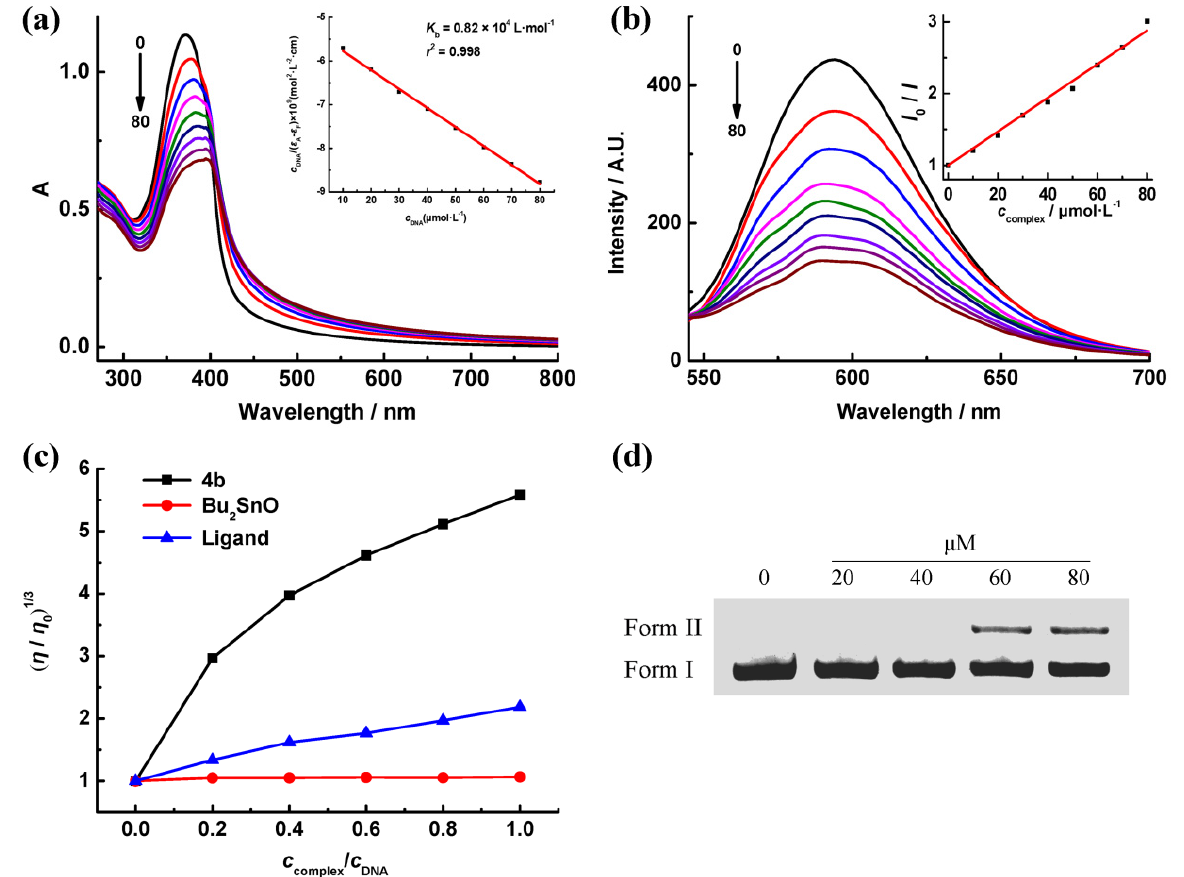
Figure 7. The binding of the complex 4b and DNA, ( a ) UV–Vis absorption spectra of 4b (50 µ M) in the absence and presence of CT-DNA (0–80 µ M), inset: plot of c DNA /( ε A − ε F ) vs. c DNA , ( b ) effects of 4b (0–80 µ M) on the fluorescent spectra of EB-DNA (30 µ M) system, λ ex = 258 nm, inset: plot of I 0 / I vs. c complex , ( c ) effect of increasing amounts of the 4b , Bu 2 SnO, and ligand, ( d ) agarose gel electrophoresis of pBR322 treated with different concentrations of 4b (0–80 µ M).